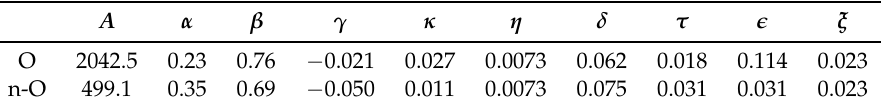
Table 1. Non-spillover parameters.